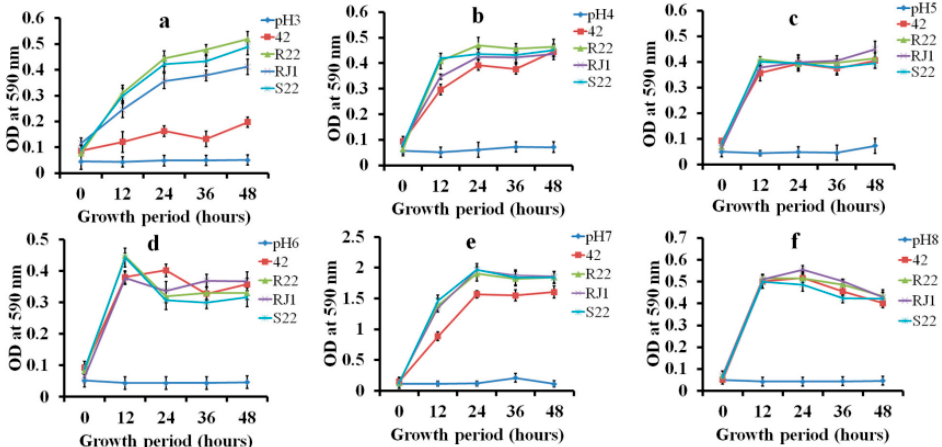
Figure 1. Growth ability of selected Lactobacilli strains ( L. plantarum RJ1 and P. pentosaceus S22) in